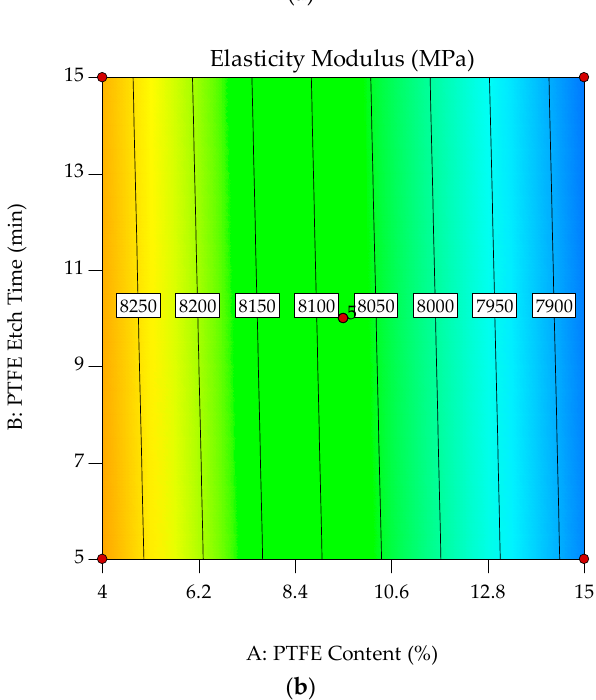
Figure 7. 3D response surface plot ( a ) with 2D contour plot; ( b ) of the effects of PTFE content and PTFE etch time on elasticity modulus of POM composites.